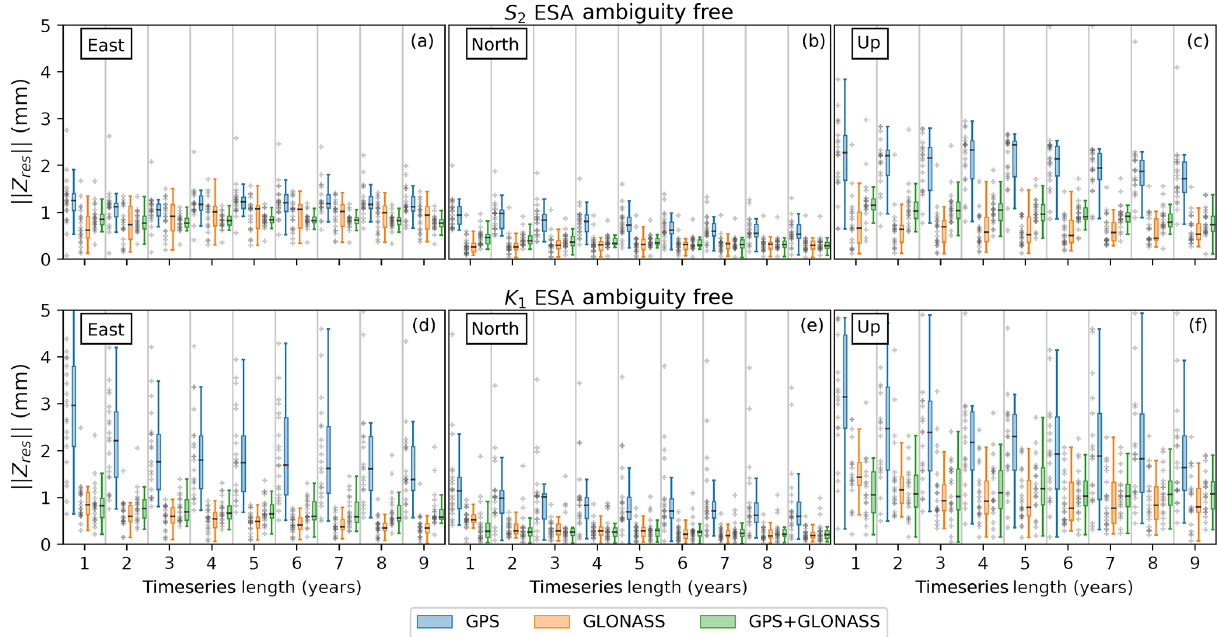
Figure 12. Dependency of estimated (cid:107) Z res (cid:107) and time series’ length in years for two solar-related constituents: S 2 (a–c) and K 1 (d–f) . GPS, GLONASS and GPS+GLONASS PPP solutions are in blue, orange and green, respectively, using ESA products. Grey crosses are as per Fig. 3. Note that 1–4 years of time series length use ESA repro2, while the rest use a combination of ESA repro2 and ESA operational